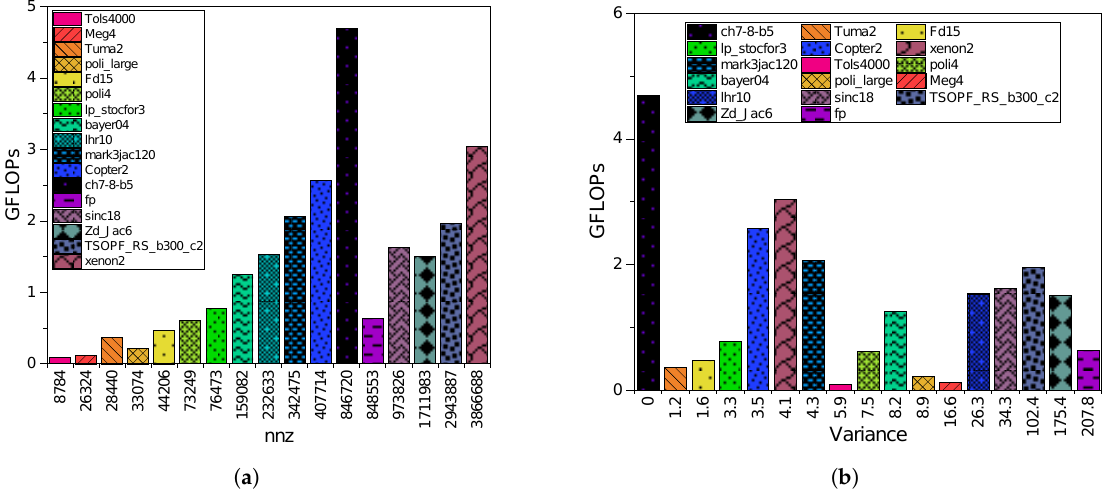
Figure 2. CSR giga floating point operations per second (GFLOPS) against: ( a ) nnz and ( b ) npr variance